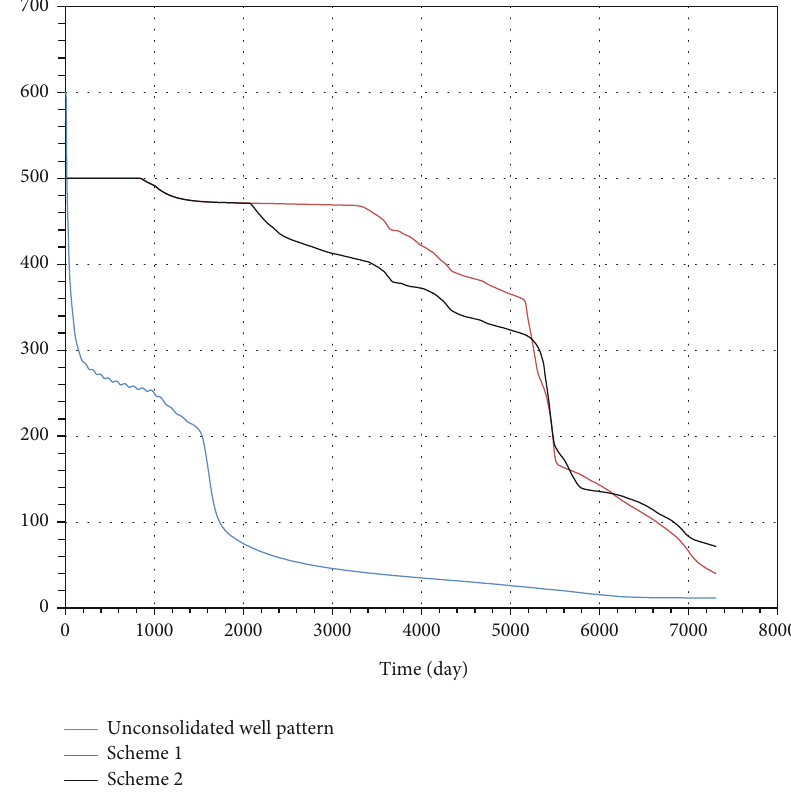
Figure 13: The relationship between production time and oil